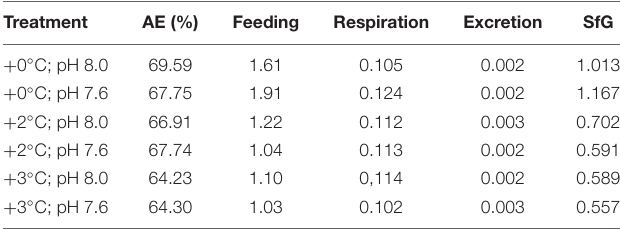
TABLE 3 | Scope for growth (SfG) in Heliocidaris erythrogramma . Treatment AE (%) Feeding Respiration Excretion